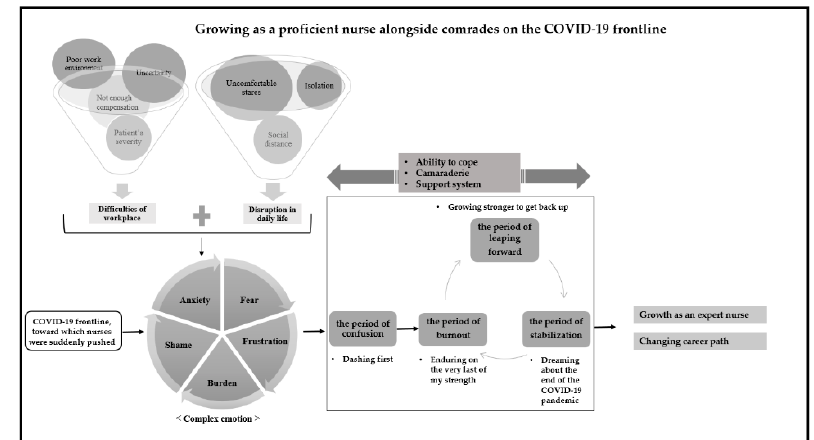
Figure 1. Nurses’ adaptation process in caring for COVID-19 patients. Table 1. Paradigm, categories, and subcategories of nurses’ adaptation processes in caring for COVID-19 patients. Paradigm